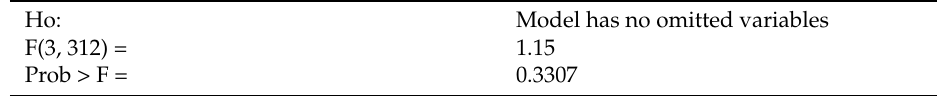
Table A1. Ramsey RESET test using powers of the fitted values of lne.